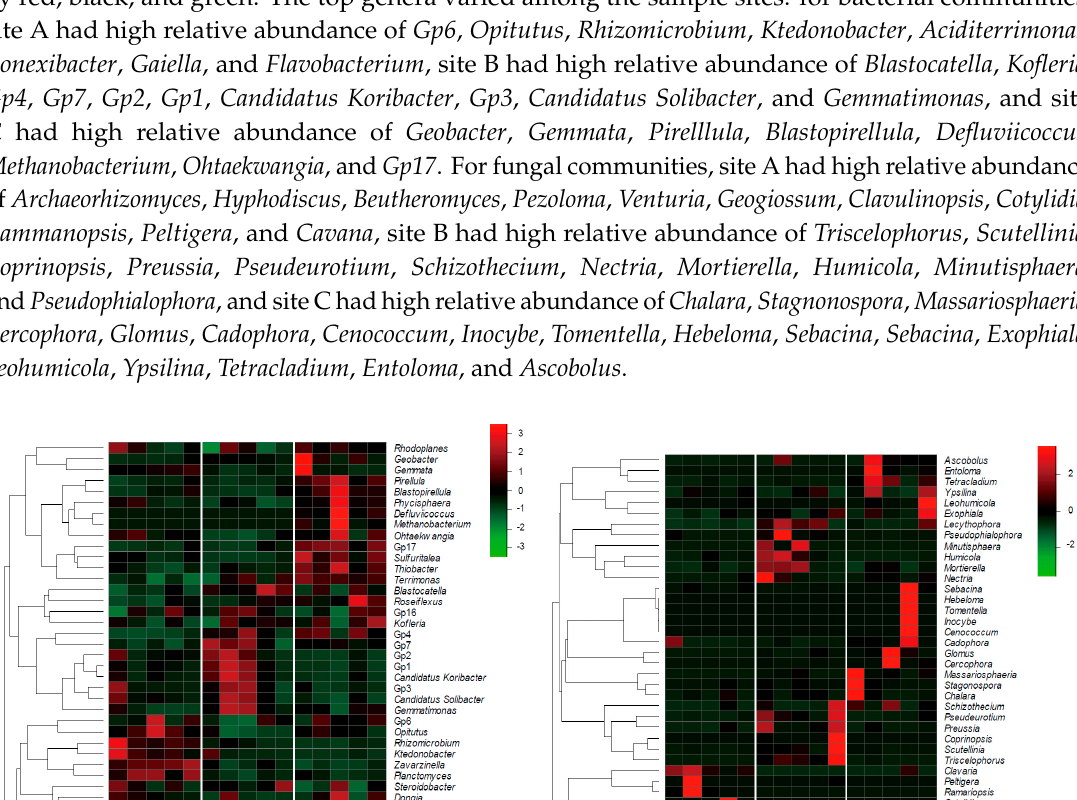
Figure 5. Heatmaps of top 40 genera of soil ( a ) bacterial and ( b ) fungal communities at each site. Relative abundance of soil microbial community from high to low is represented by red, black, and green.